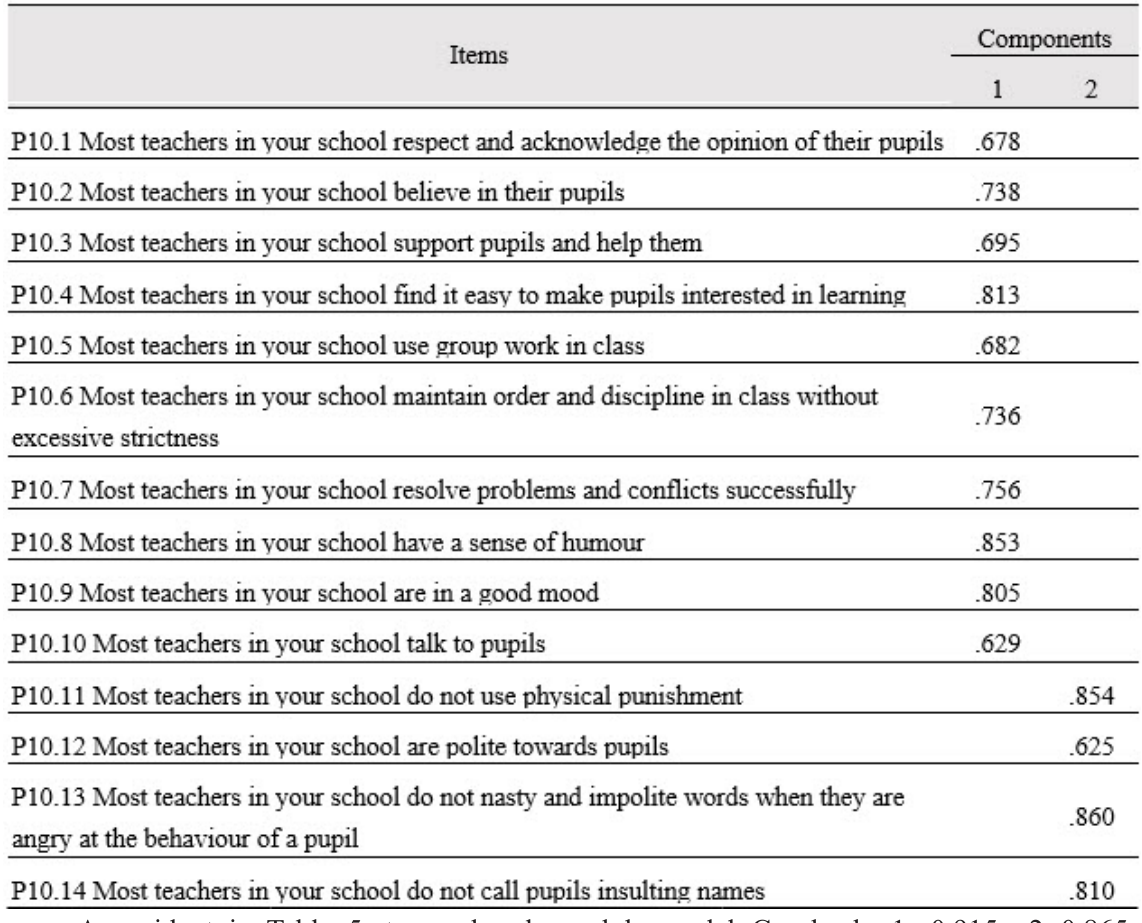
Table 5. Compound